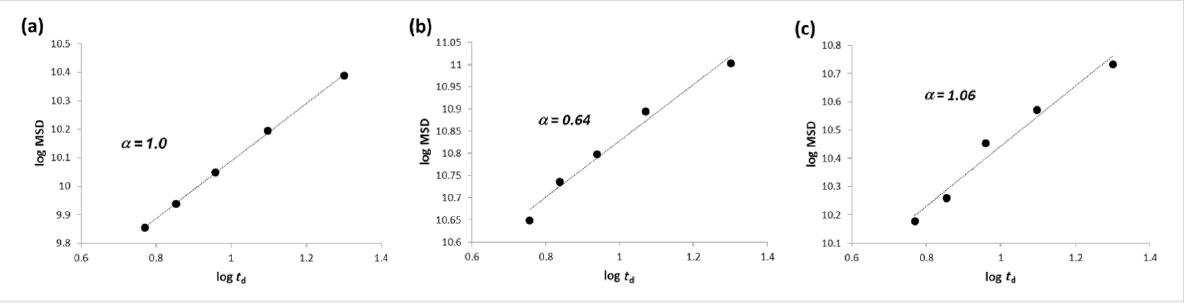
Figure 3: log–log plot of MSD vs diffusion time t d for: a) D 2 O solution, b) CDNSEDTA (1:4) and CDNSEDTA